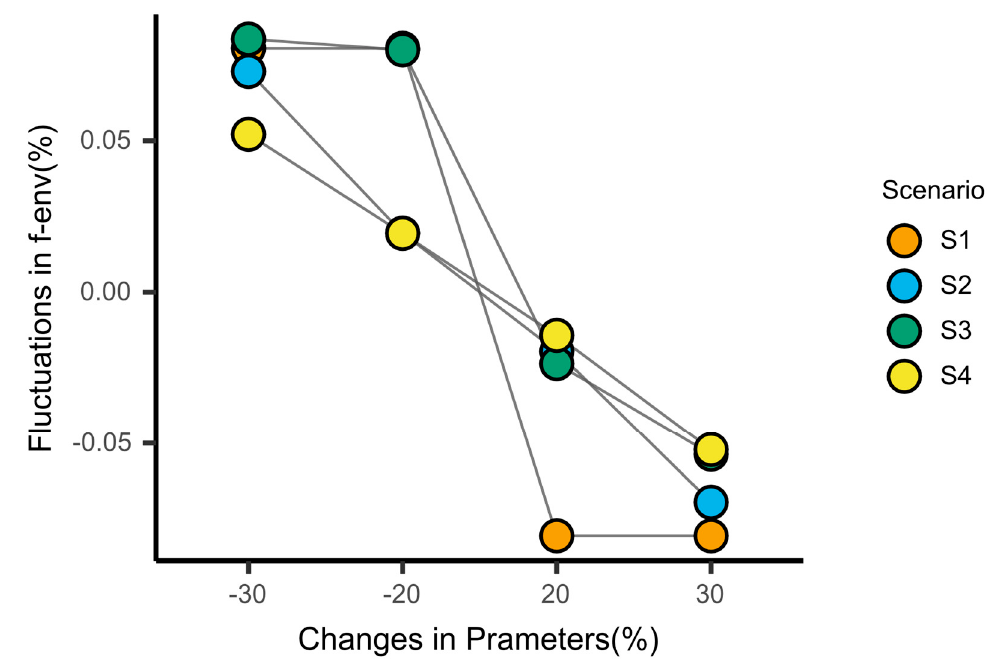
Figure 7. Sensitivity analysis of the 𝑓 (cid:3032)(cid:3030)(cid:3042) by changing parameters.